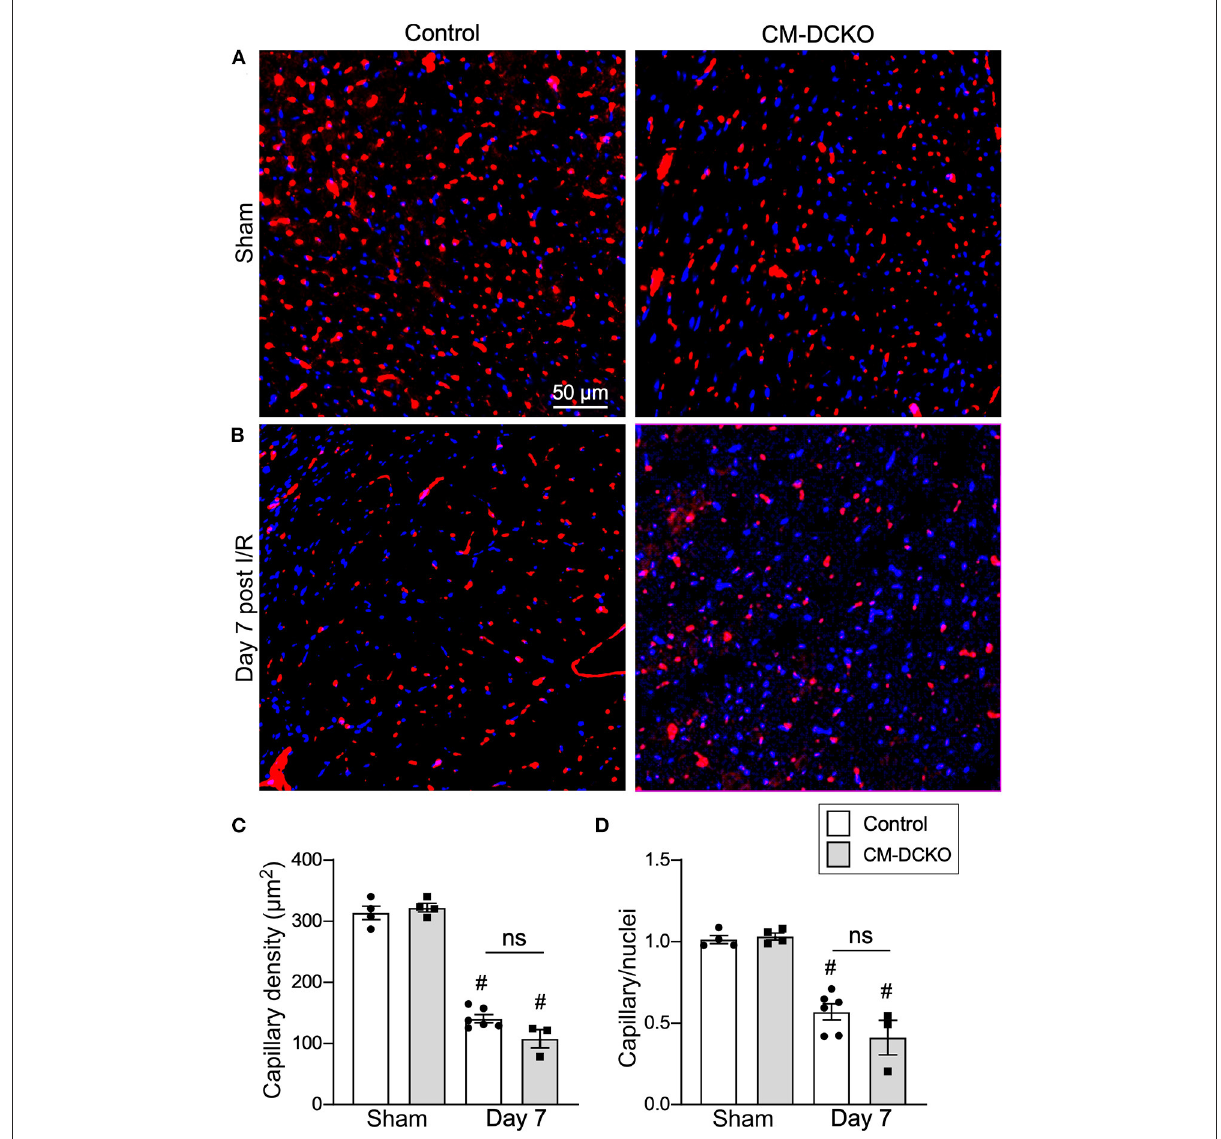
FIGURE4 Myocardial capillary density after cardiac I/R injury is not affected by lack of cardiomyocyte Fgfr1 and Fgfr2 . (A,B) Representative images of immunoflurescence for CD31 (red) and DAPI (blue) showing capillaries in the periinfarct area of Control and CM-DCKO mice 7 days after sham operated (A) or I/R injury (B) . Scale bar = 50 µ m. (C,D) Quantitation of capillary density normalized to area (C) or to nuclei (D) showing a significant capillary rarefaction in the peri-infarct area 7 days after I/R injury without a notable difference in capillary density between Control and CM-DCKO hearts. # P < 0.05 vs.